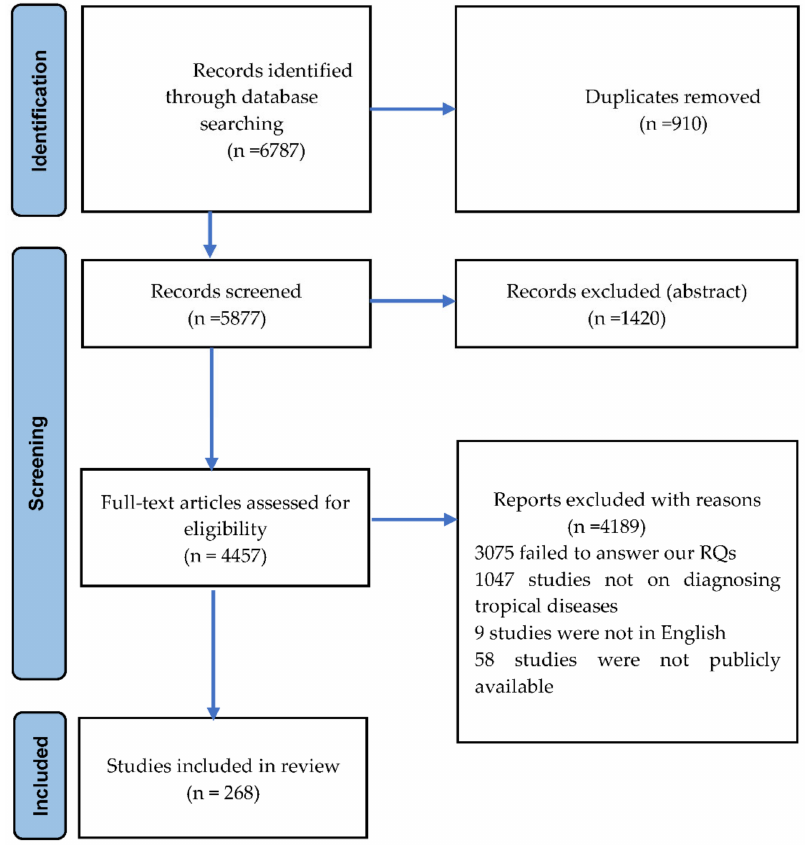
Figure 1. PRISMA flow chart illustrates the article search and the inclusion